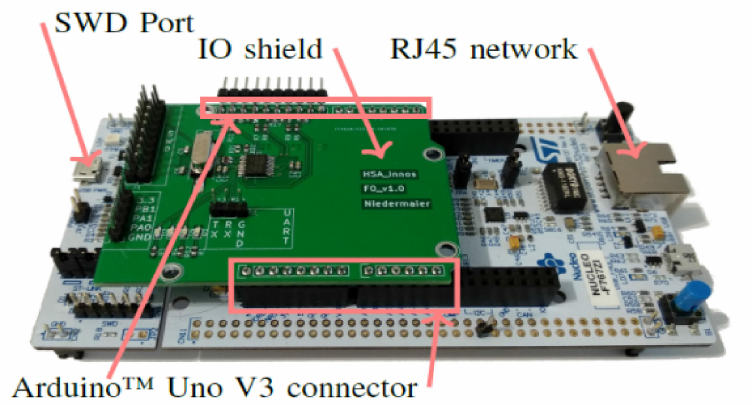
Figure 6. IoT device used in performance